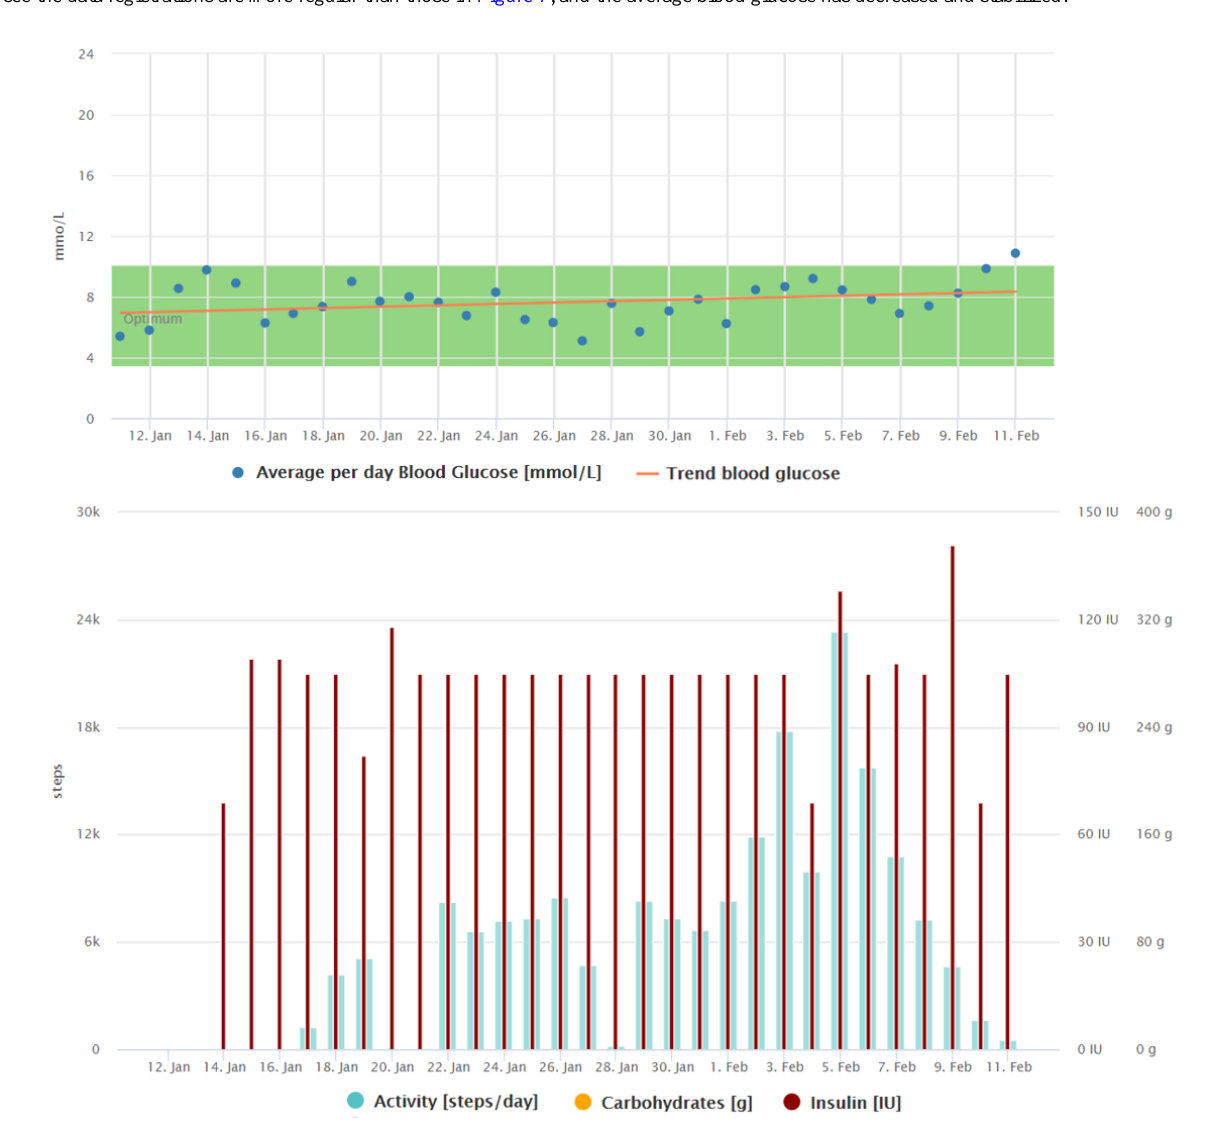
Figure 8. Graphical interpretation of 1-month data registrations of the patient from case study 5 after 2.5 months of using the telemedicine system.